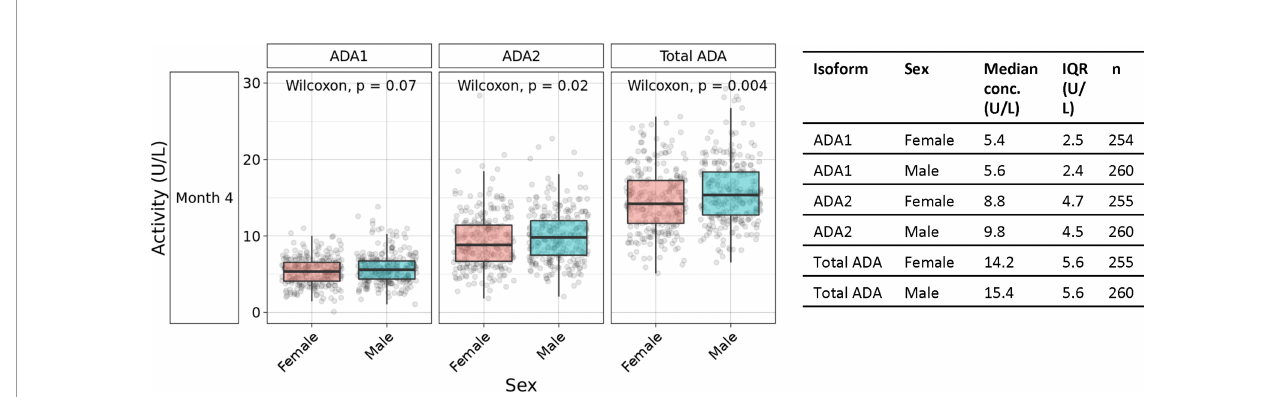
FIGURE 4 | Males exhibited higher plasma ADA2 concentrations at four months of age. Measurement of plasma ADA1, ADA2, and Total ADA in biosamples in the Gambian cohort demonstrated greater concentrations of ADA1 (p=0.07), ADA2 (p=0.02) and Total ADA (p=0.004) in males than females during the fi rst four months of life (n =254-260 per group). Statistical analyses employed Wilcoxon rank sum